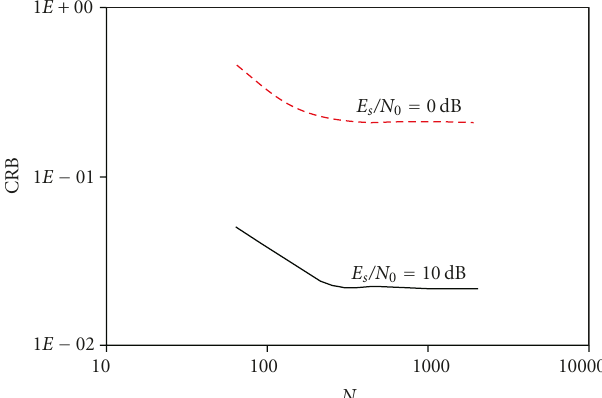
Figure 6: Influence of the FFT length N on the GCRB, M = 40, ν = 7.